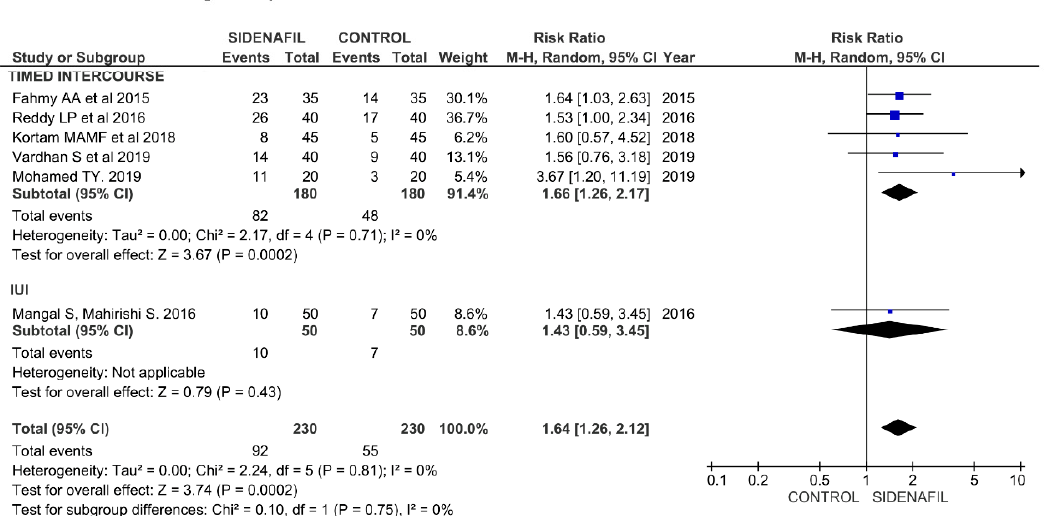
Figure 2. ( a ) Forest plot of comparison: endometrial thickness (ETh) according to group allocation—intervention (Sildenafil) versus control in intrauterine insemination and timed intercourse cycles. ( b ) Forest plot of comparison: clinical pregnancy rate (CPR) according to group allocation—intervention (Sildenafil) versus control in intrauterine insemination and timed intercourse cycles. ( c ) Forest plot of comparison: chemical pregnancy rate (ChPR) according to group allocation—intervention (Sildenafil) versus control in intrauterine insemination and timed intercourse cycles.